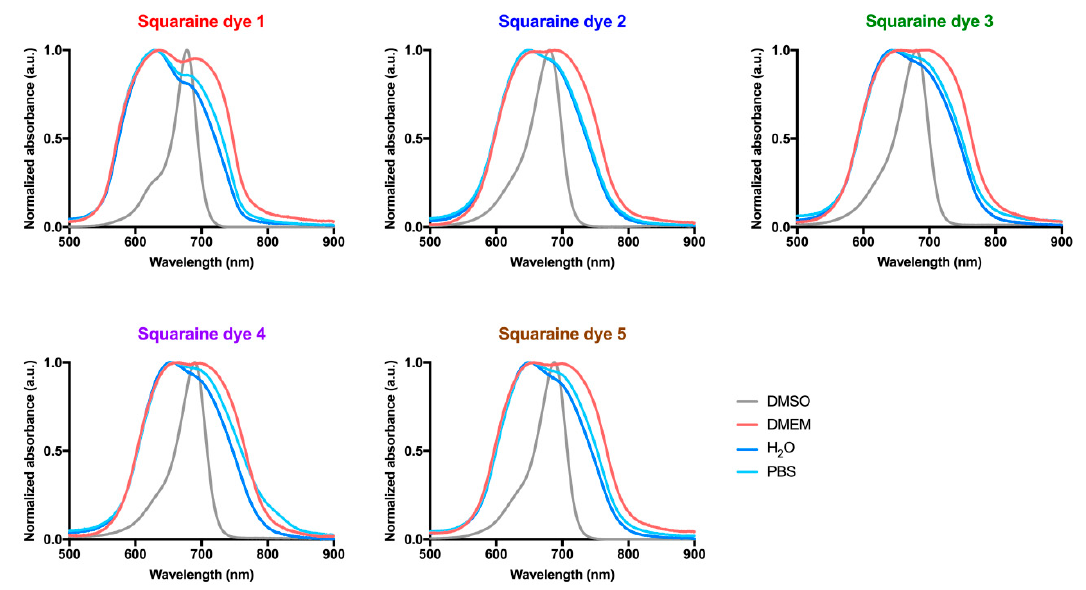
Figure 2. Absorption spectra of dicyanomethylene squaraine dyes 1 – 5 in dimethyl sulfoxide (DMSO), serum-free Dulbecco’s Modified Eagle Medium (DMEM), water, and phosphate-buffered saline (PBS). Absorbance was normalized and is present as arbitrary units (a.u.).